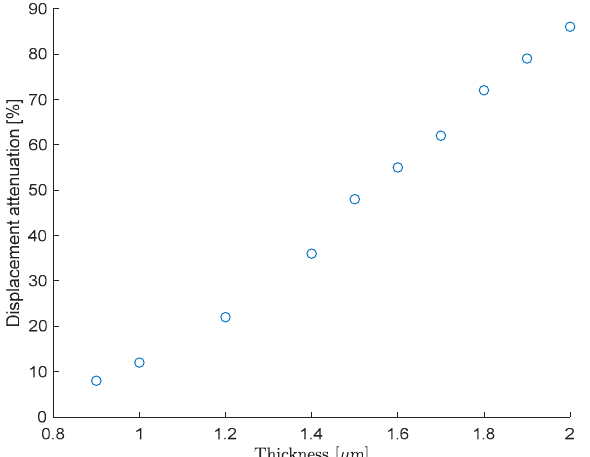
Figure 3. The influence of beam thickness on the attenuation of the displacement amplitude.